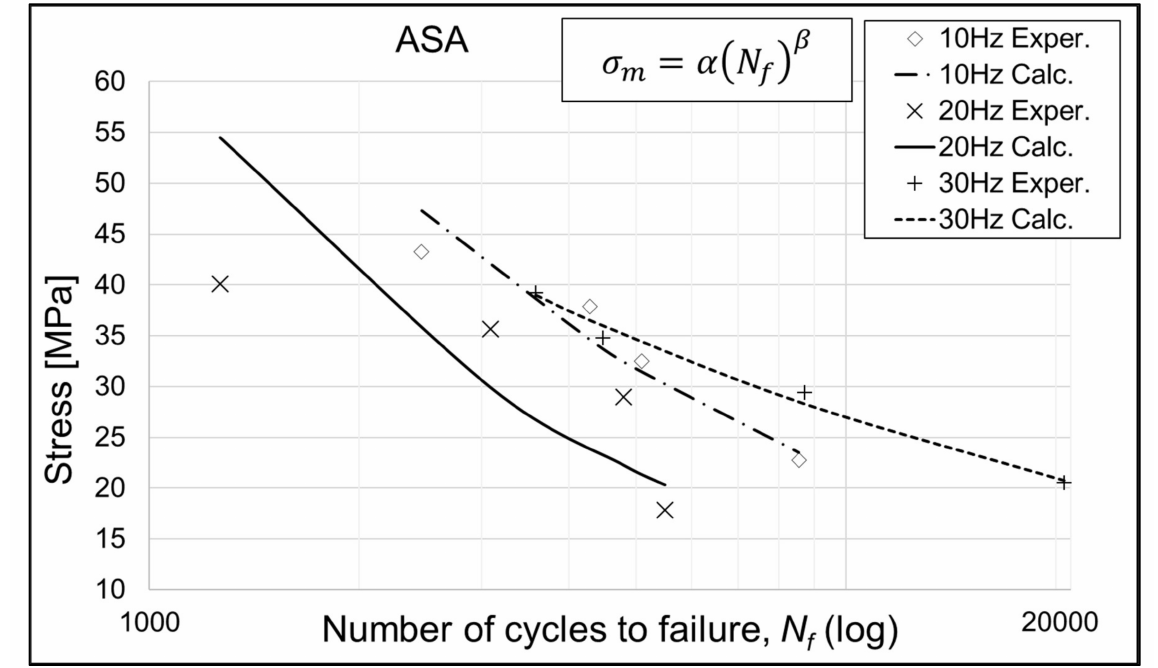
Figure 6. S–N curves for ASA+ specimens. Exper.—Experimental;